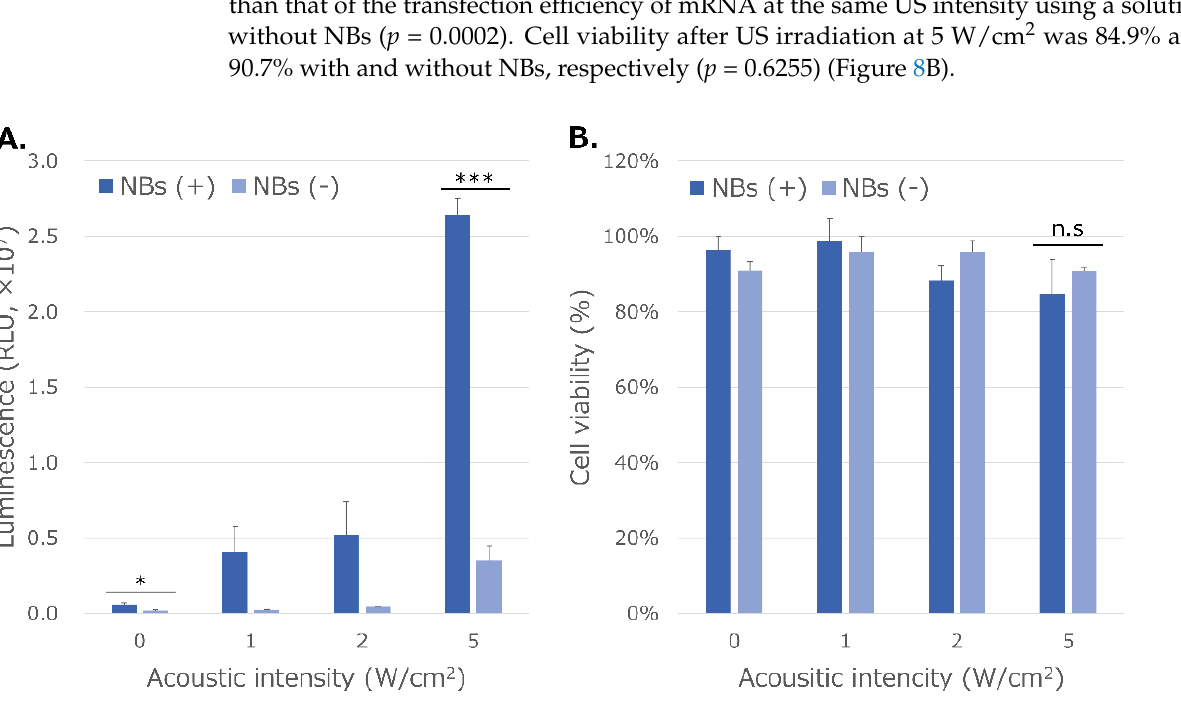
Figure 8. mRNA transfection efficiency ( A ) and cell viability ( B ) by sonoporation using NBs regen- erated from lyophilized material. NBs (+): solution with nanobubbles, NBs ( − ): solution without nanobubbles. (* p < 0.05; *** p < 0.001; n.s: not significant) ( N = 3).